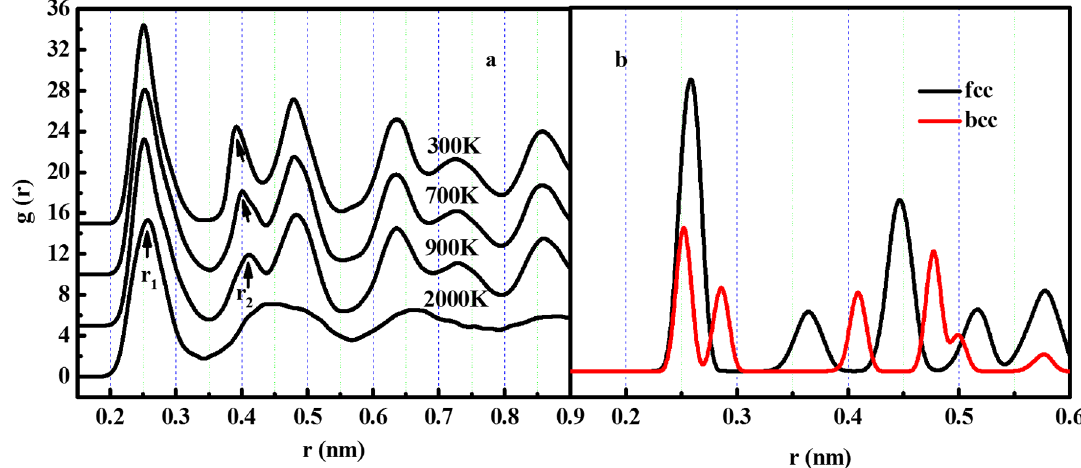
Figure 2. The PDF of iron at different temperatures. left: at 1.4GPa. right: the PDF of fcc and bcc of